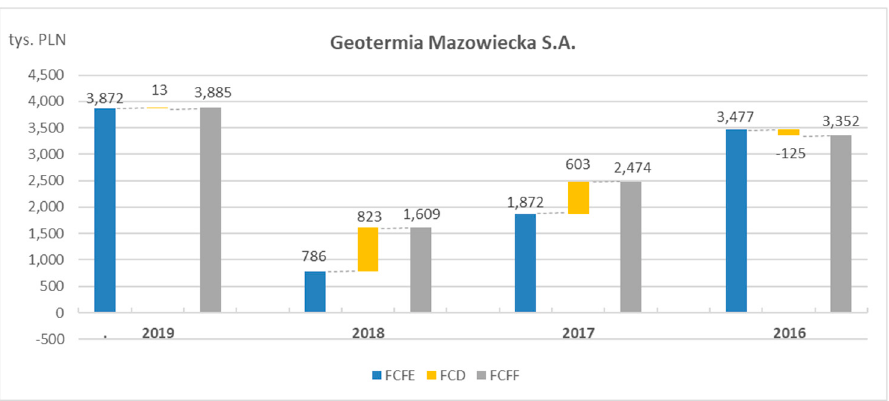
Figure 7. Formation of FCFE, FCD and FCFF in Geotermia Mazowiecka S.A. Source: Own study on the basis of: [53].